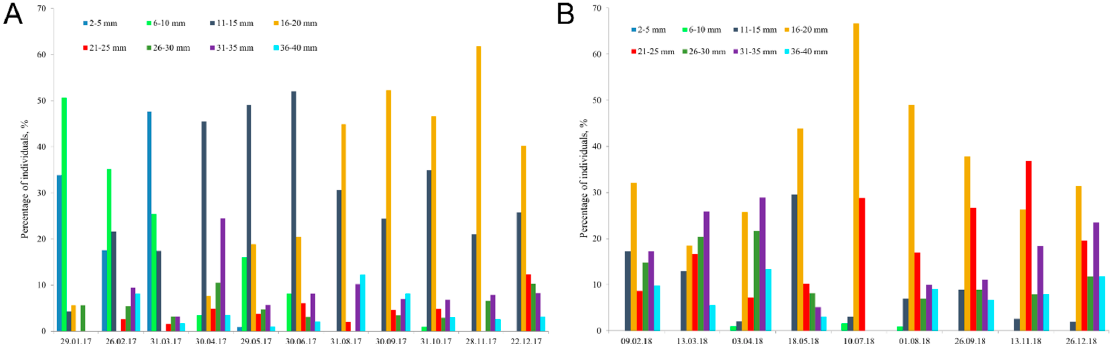
Figure 3. Seasonal changes of shell size structure in the Corbicula morphotype R population. Axes correspond to the eight size classes in accordance with shell length intervals. The juvenile individuals belong to a size class with shell length of 2–5 mm. ( A ) 2017, ( B )